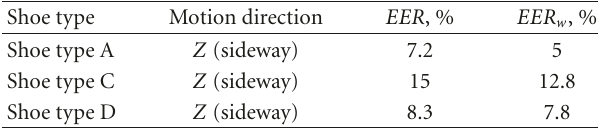
Table 7: The unweighted ( EER ) and weighted distances ( EER w ).